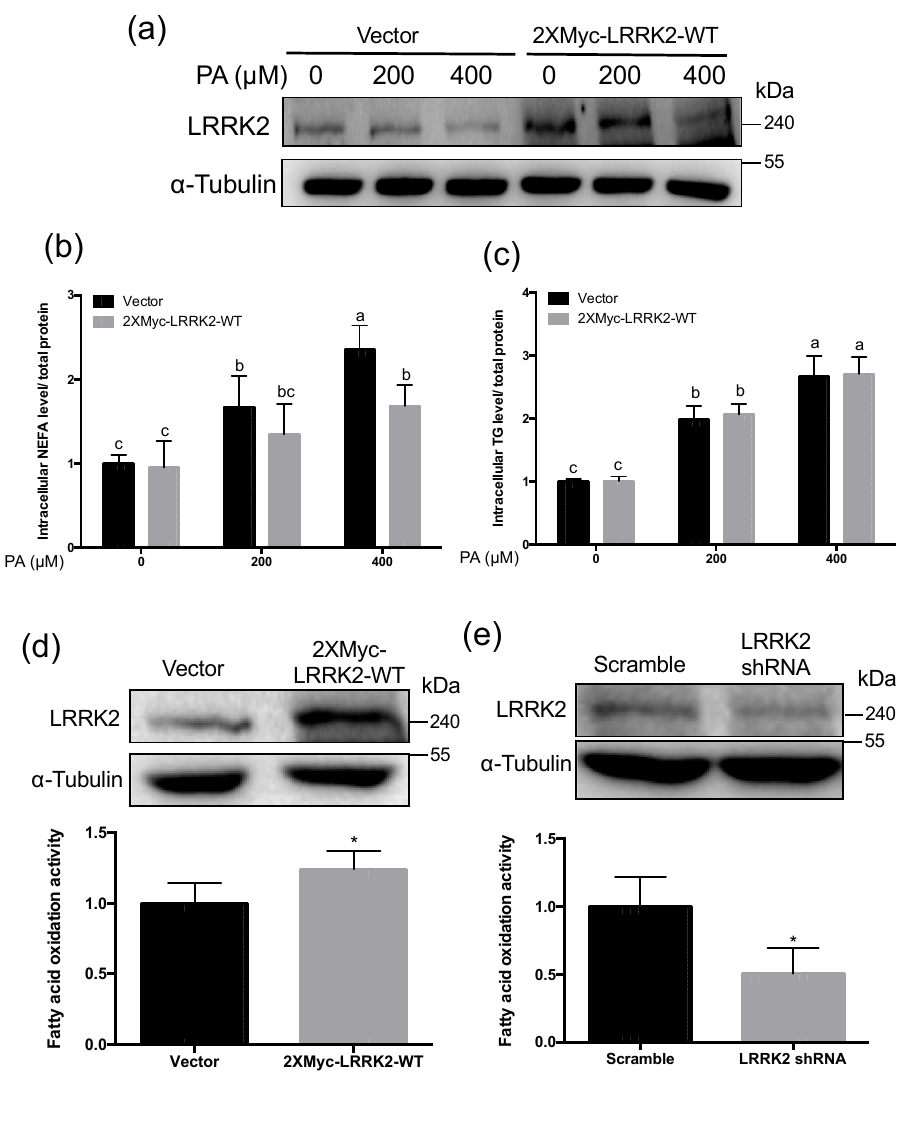
Figure 3. Overexpression of LRRK2 promoted catabolism of free fatty acid in palmitic acid (PA)- treated HepG2 cells. ( a ) The HepG2 transfect with 2XMyc-LRRK2-WT plasmid was as LRRK2- overexpressed group. The HepG2 cells transfected with control plasmid was as vector control. Both the control and the LRRK2- overexpressed HepG2 cells were treated with PA at 0, 200 or 400 μ M, respectively. ( b ) The levels of intracellular NEFA ( n = 5 for each group) and ( c ) intracellular TG ( n = 3 for each group) were measured. The levels of intracellular NEFA and TG were normalized with the protein concentration of the individual lysate. Data are shown as mean ± SD. Two-way ANOVA, *